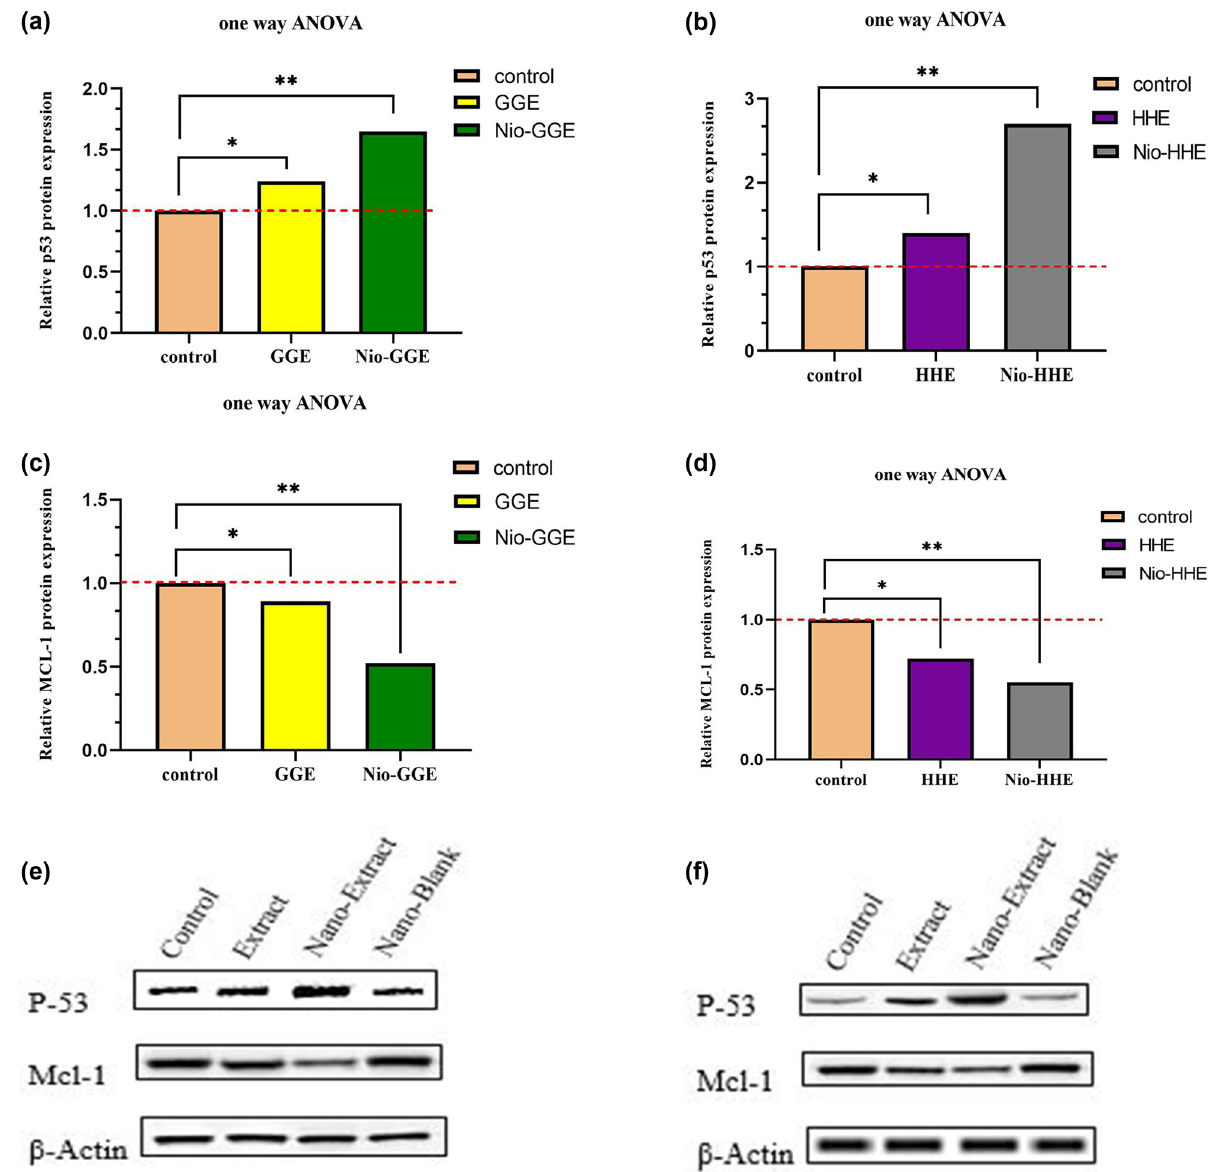
Figure 11: ( a ) Changes in expression of p53 protein in MCF - 7 cells after treatment with GGE and Nio - GGE. ( b ) Changes in expression of p53 protein in MCF - 7 cells after treatment with HHE and Nio - HHE. ( c ) Changes in expression of MCL - 1 protein in MCF - 7 cells after treatment with GGE and Nio - GGE. ( d ) Changes in expression of MCL - 1 protein in MCF - 7 cells after tratment with HHE and Nio - HHE. ( e ) Gel retardation assay to evaluate the genes expression in MCF - 7 cells after treatment with GGE and Nio - GGE. ( f ) Gel retardation assay to evaluate the gene expression in MCF - 7 cells after treatment with HHE and Nio - HHE. ns: no signi fi cant di ff erence. *, **: P - value <